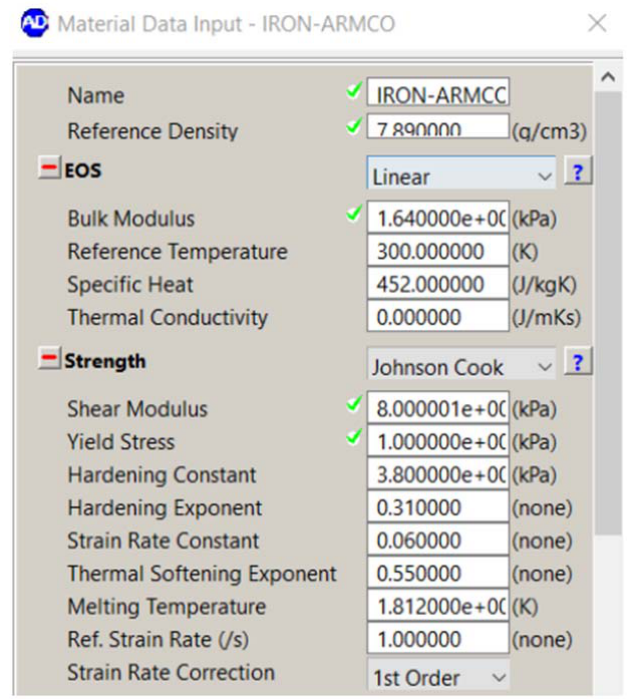
Figure 16. Characteristics of iron used in numerical simulation (Autodyn) [8]